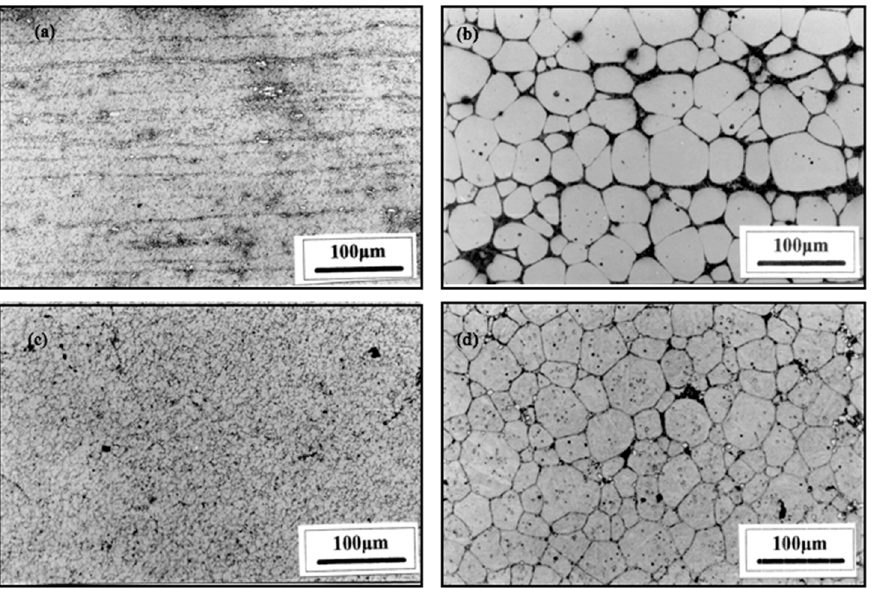
Figure 3. Examples of thixoformed microstructures obtained from: ( a ) extruded and ( c ) sprayformed feedstock materials; ( b , d ) show the resultant microstructures after thixoforming [20].